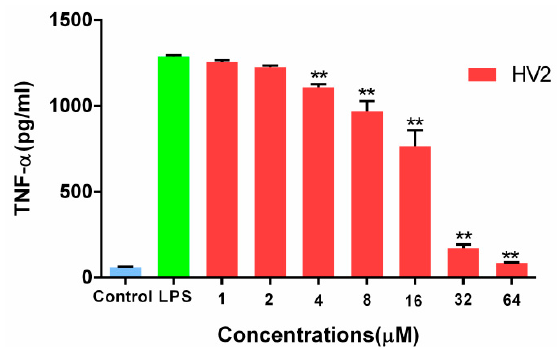
Figure 11. Effects of HV2 on LPS-stimulated TNF- α production in RAW 264.7 cells. Amounts of TNF- α in cell culture supernatants were determined by ELISA and the Griess reagent, respectively. Data shown are the mean ± SEM of three independent experiments: ( ∗∗ ) p < 0.01, compared to the LPS- alone treated.